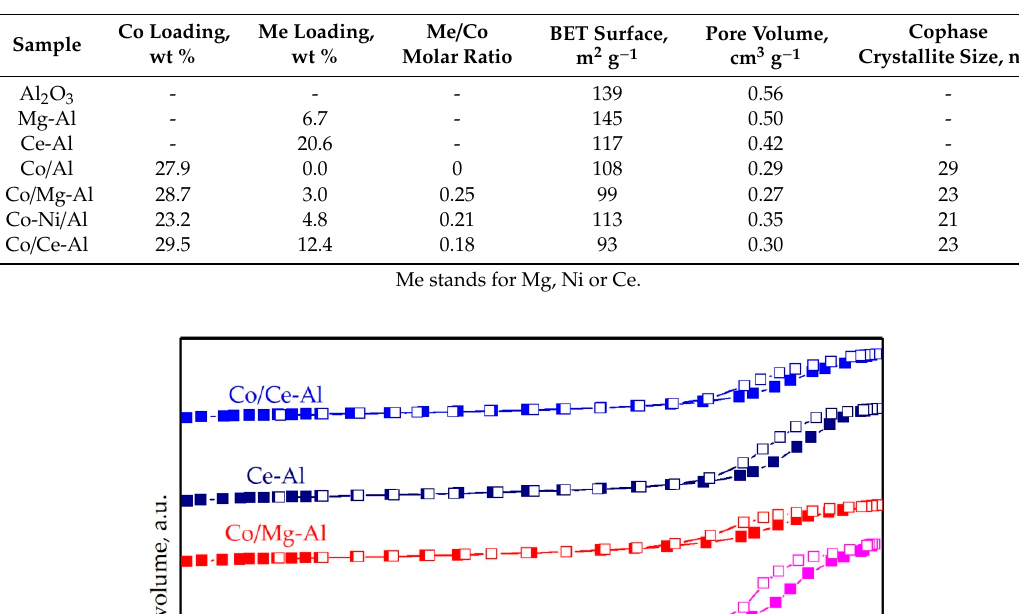
Table 1. Physico-chemical properties of the supported cobalt catalysts.